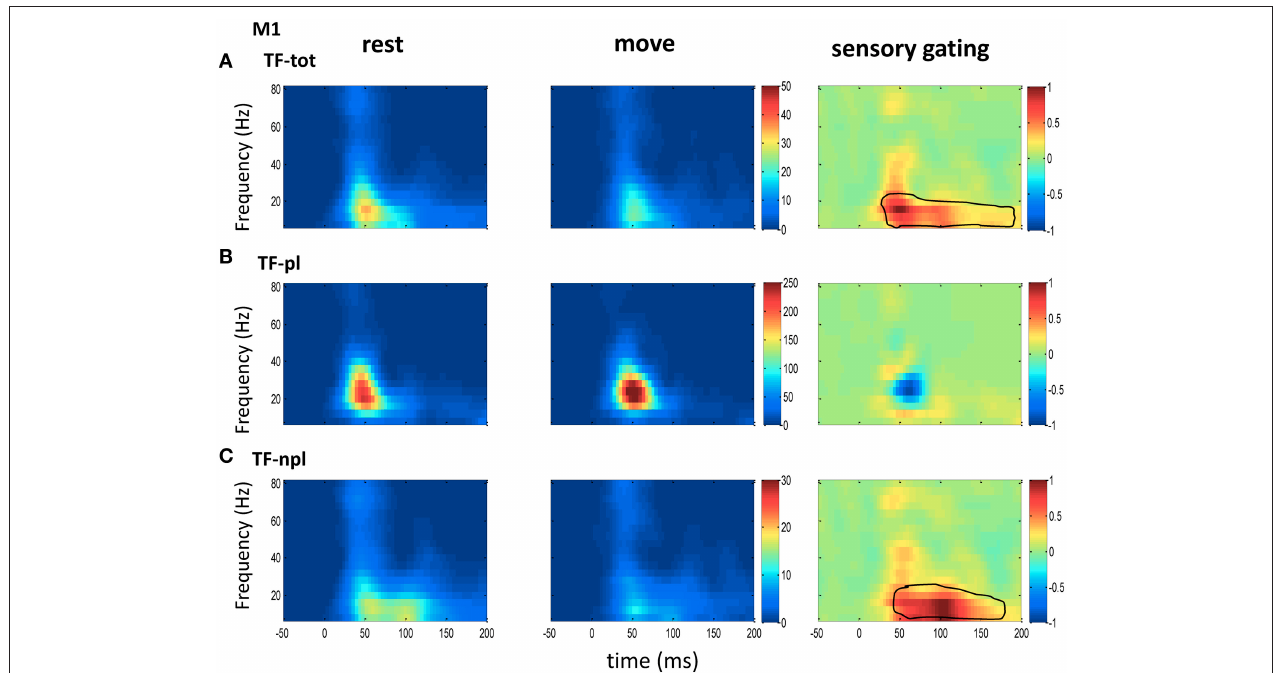
FIGURE 4 | The grand average powers in M1. (A) Different from the powers in sensory areas (VPL of Figure 2 and S1 of Figure 3 ), total powers during rest (left) and move (middle) in M1 show oscillatory activities dominantly at low frequency band. Movement induced sensory gating is also at low frequency band, which starts earlier than those in sensory areas (VPL and S1). (B) The phase-locked power shows similar pattern to that of total power, but different from the total power, instead of sensory gating, there is a small sensory elevation at low gamma band. (C) Compared the non-phase-locked power with sensory areas, the sensory gating in M1 only presents at low frequency band. The same convention of the colorbar and normalization is used in each map as in Figure 2 ( p < 0.05 for signrank test, n = 16